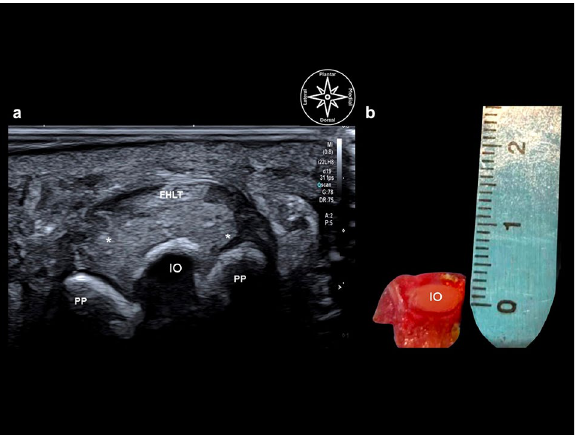
Figure 3. Comparison between diagnostic ultrasound ( a ) and gross anatomy of the interphalangeal ossicle in the axial view (short axis). ( b ) PP proximal phalanx, IO interphalangeal ossicle (5.8 mm), FHLT flexor hallucis longus tendon, asterix* plantar plate, IO interphalangeal ossicle (6 mm).